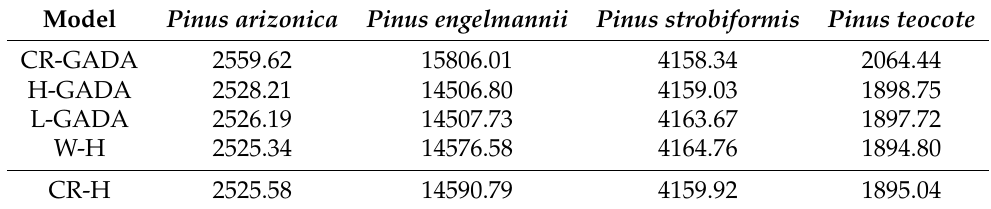
Table 7. AIC results for each species and model of the study.